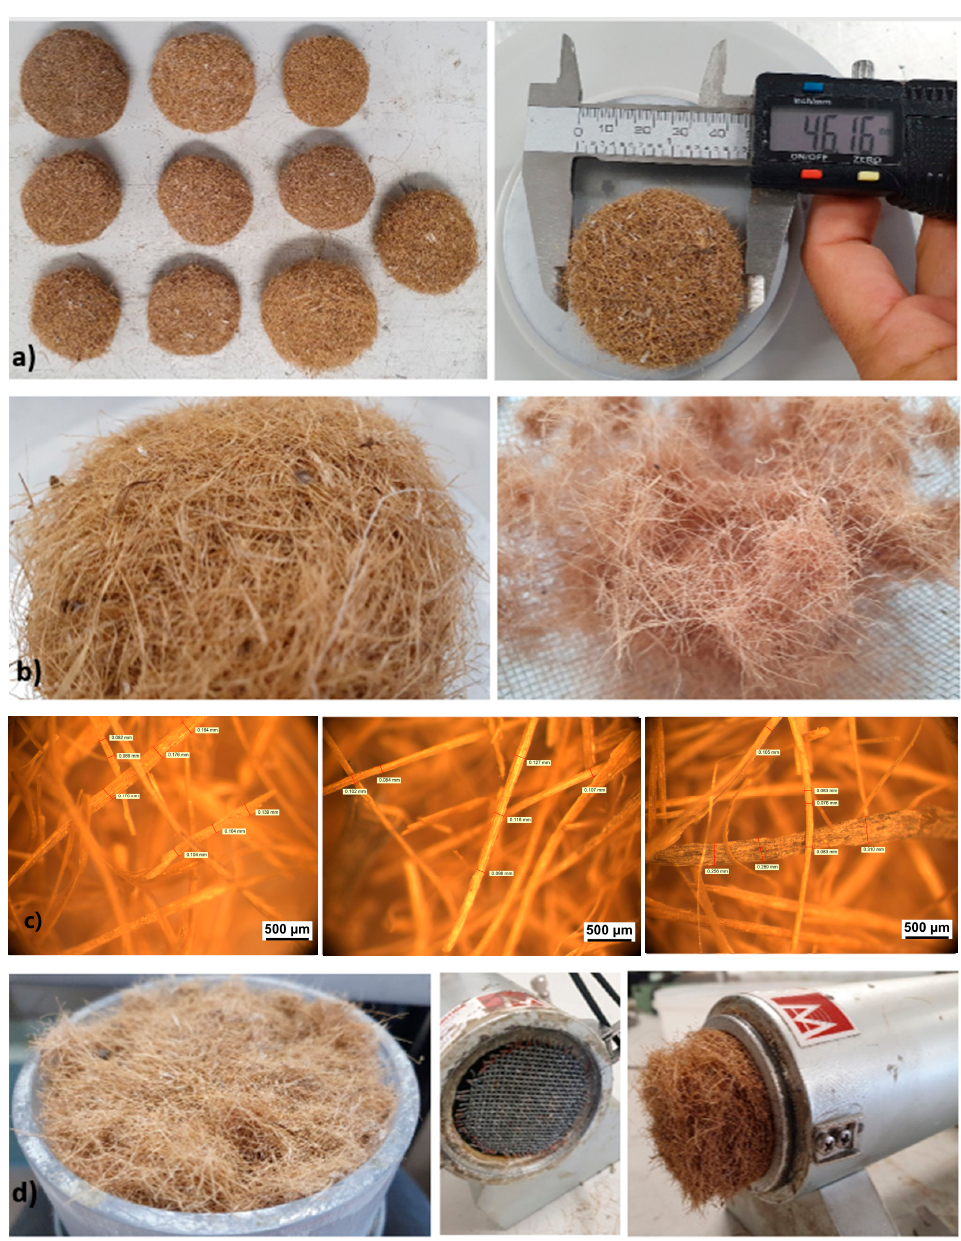
Figure 2. Collected Posidonia Balls ( a ), fibers obtained from the aggregates ( b ), microscope pictures of the fibers ( c ), fibers inside the sample holders for the measurement of airflow resistance ( left ) and sound absorption at normal incidence ( right ). In the center, the front grid for the compression of the sample ( d ).